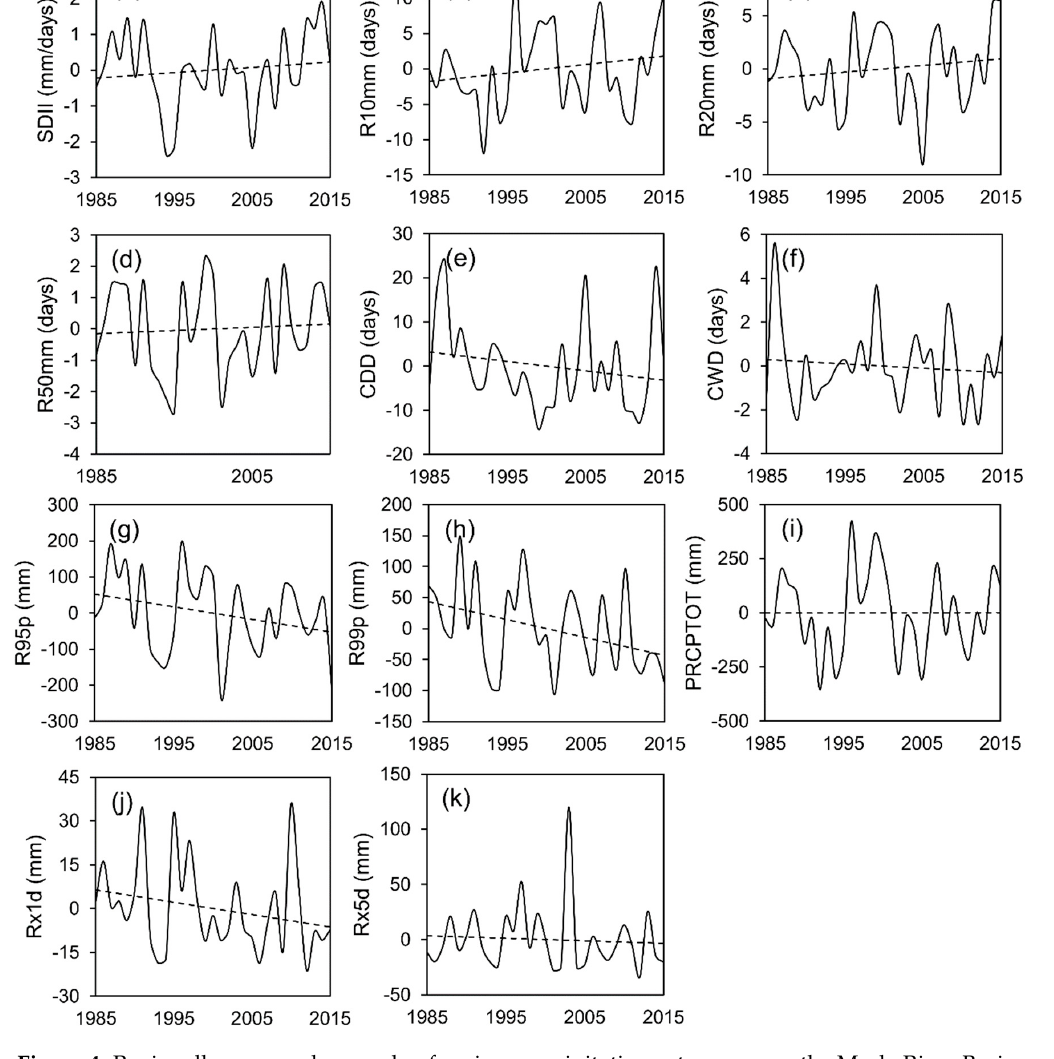
Figure 4. Regionally averaged anomaly of various precipitation extremes over the Muda River Basin from 1985 to 2015, ( a ) SDII; ( b ) R10mm; ( c ) R20mm; ( d ) R50mm; ( e ) CDD; ( f ) CWD; ( g ) R95p; ( h ) R99p; ( i ) PRCPTOT; ( j ) Rx1d; ( k ) Rx5d.